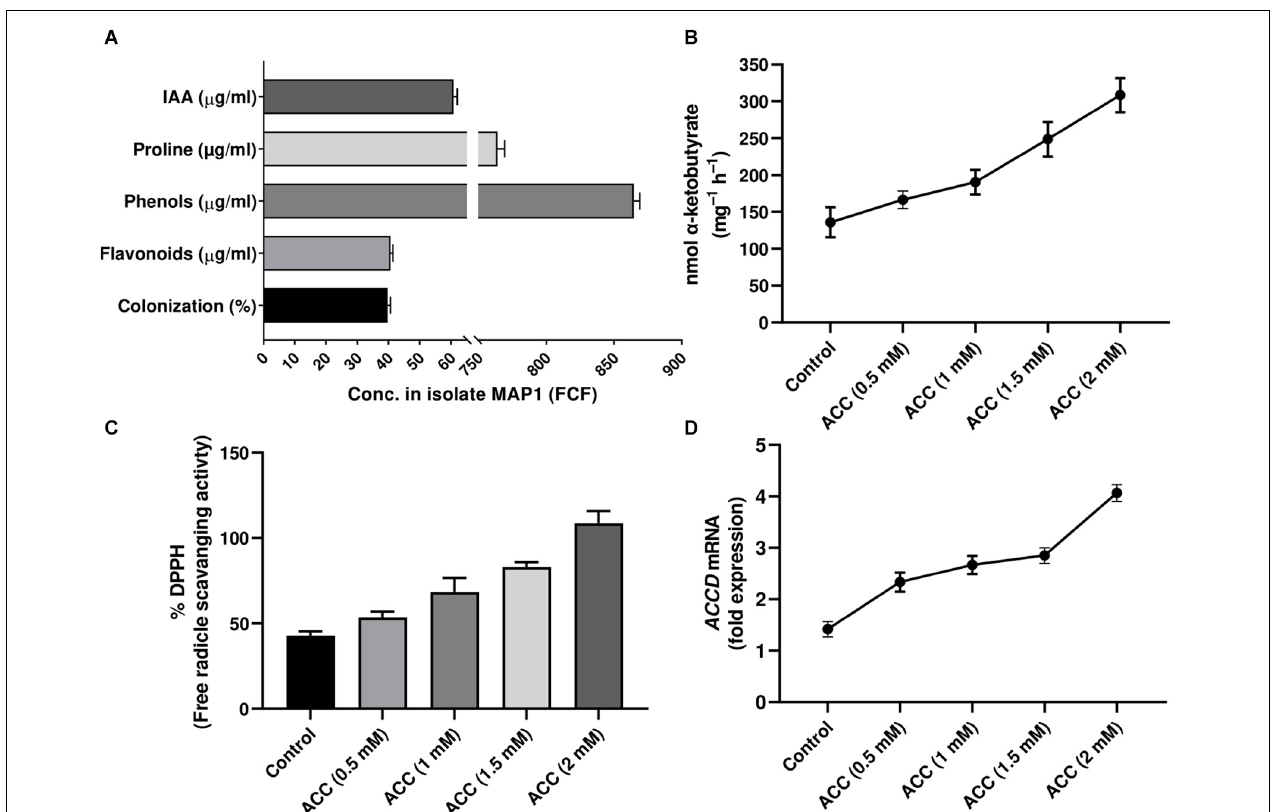
FIGURE 1 | Characterization of MAP1 isolate. (A) IAA, proline, phenols, flavonoid content, and root colonization. (B) ACC deaminase activity. (C) %DPPH, free radical scavenging activity. (D) ACC deaminase gene expression of MAP1. Quantitative data represent means ± SD of three independent experiments and at least six technical